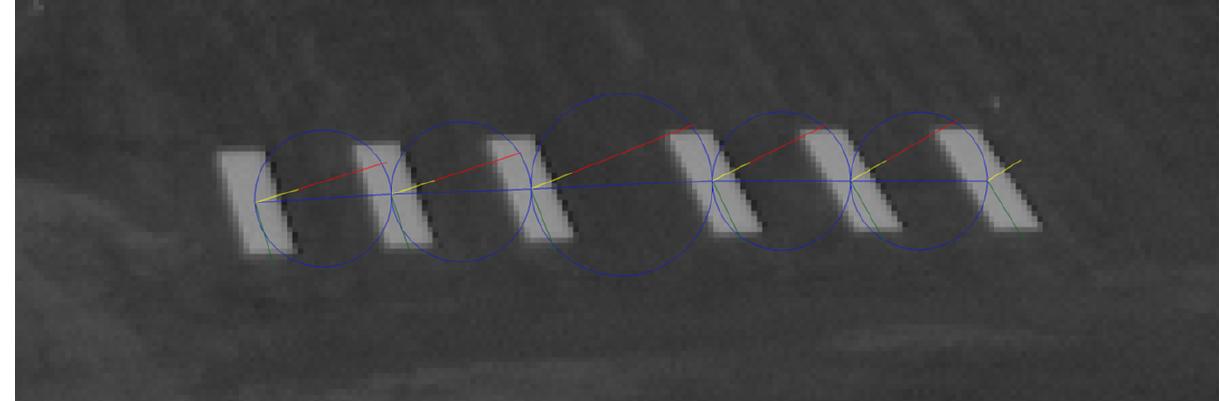
Figure 5. Visualization of the components of succession cost. Center points of candidates are connected by blue lines, and a circle represents the points with equal distance from both center points. Yellow line is the normal vector of the main (longitudinal) orientation of a bar and the red vector has R WD ∗ width length.